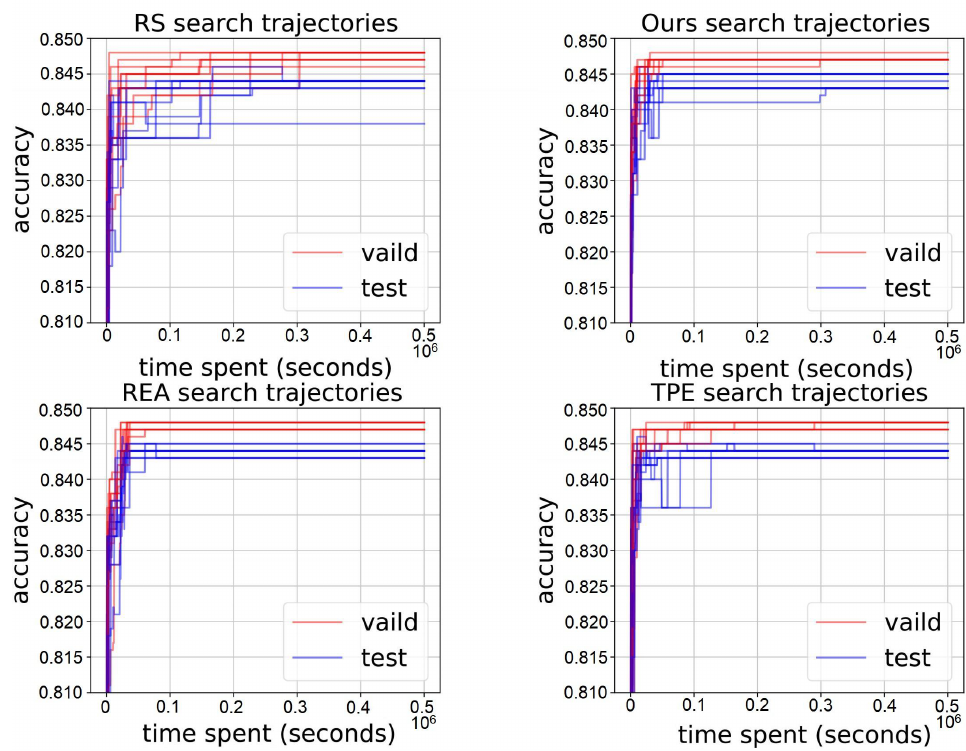
Figure 4. Search trajectories of Random search, REA, and QDO on